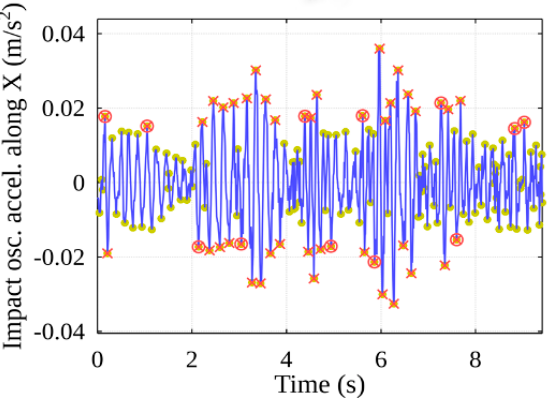
Figure 30. Result of stages of the event detection algorithm. From the total value of potential events (Figure 29, yellow dots), only those for which the peak amplitudes are equal to or greater than the set threshold are selected. In this